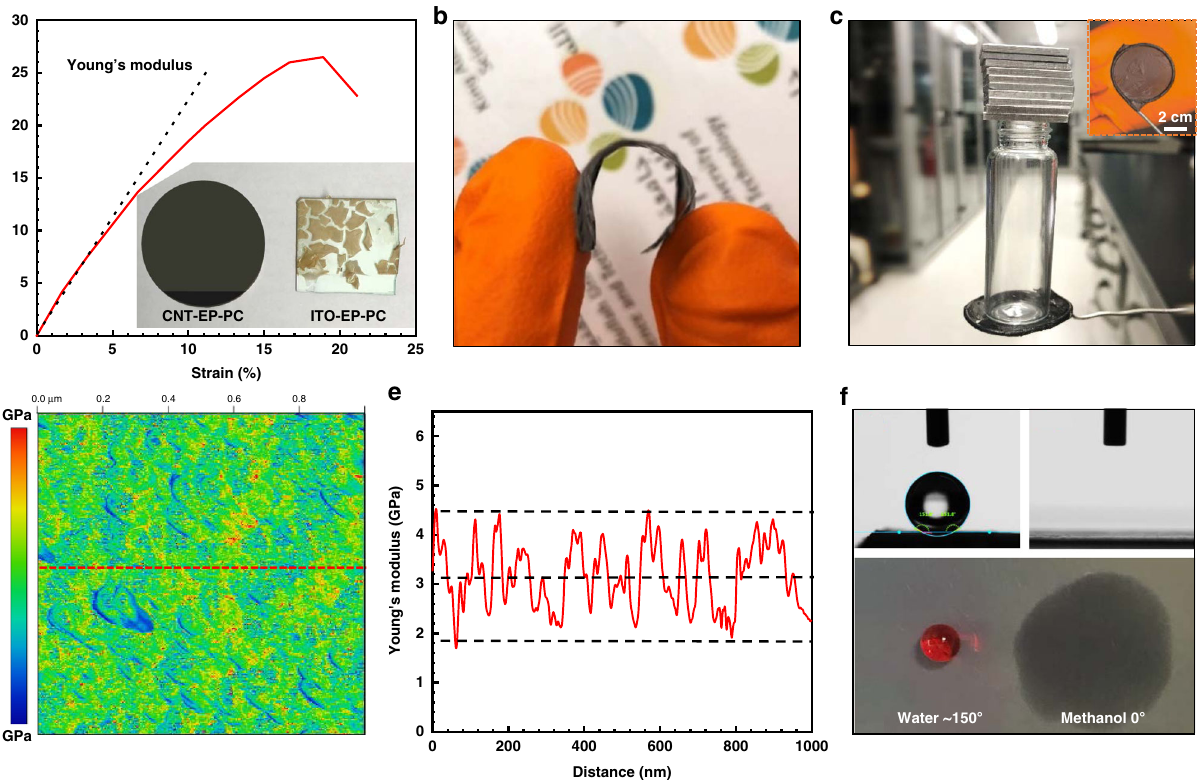
Fig. 4 Mechanical properties and wettability of the CNT-EP-PC15 membrane. a Stress vs. Strain curve measured by the standard tensile test. Inset: photographs of a CNT-EP-PC15 membrane and an ITO-EP-PC15 fi lm fabricated on the dense ITO glass. b Photograph of the fl exible CNT-EP-PC15 membrane; c Photograph of the CNT-EP-PC15 membrane holding a vial bottle and ten metal blocks. The total weight of the vial bottle and the metal blocks was about 8000-12000 times greater than the weight of CNT-EP-PC15 membrane itself. d AFM image showing the peak force quantitative nanomechanical mapping (PFQNM) curve. e The Young ’ s modulus pro fi le along the PFQNM curve; and f Contact angle measurements of water (left) and methanol (right) on the CNT-EP-PC15